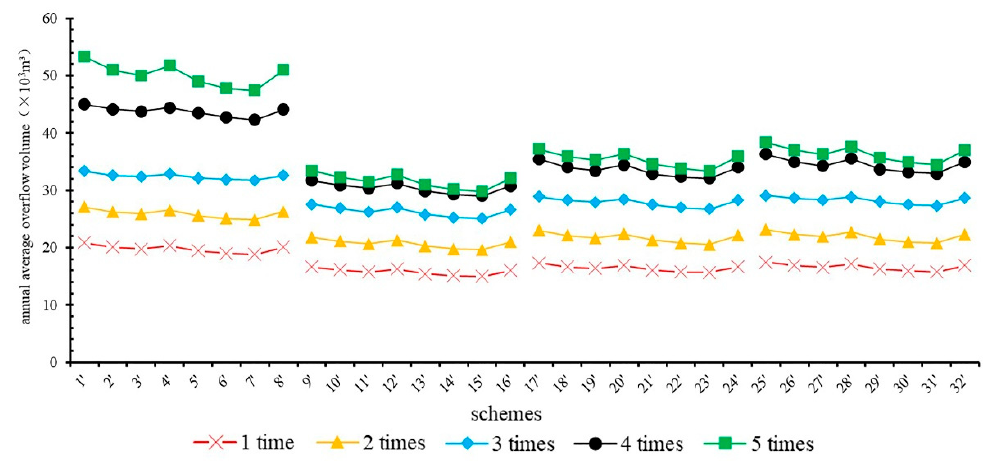
ff erent control